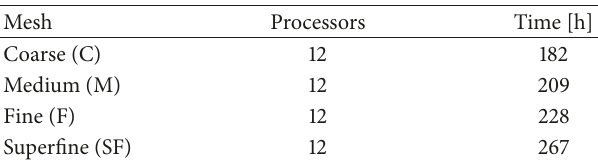
Figure 16: Mass fractions of CO2, H2O, and CH3OH. Table 4: Computational